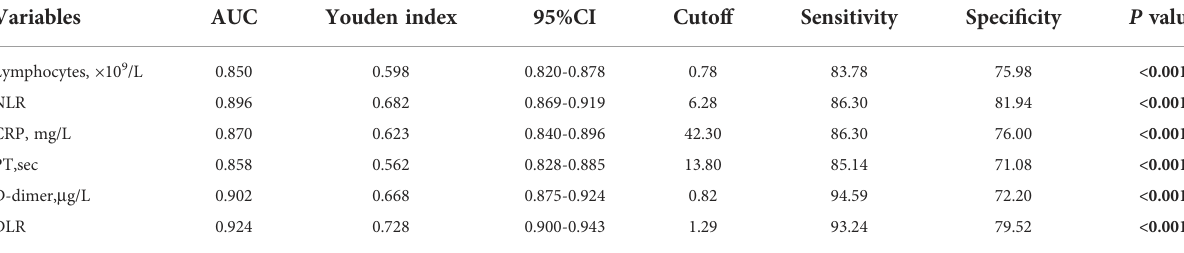
TABLE 5 Comparison of the biomarkers for predicting the prognosis of COVID-19 patients using ROC analysis.